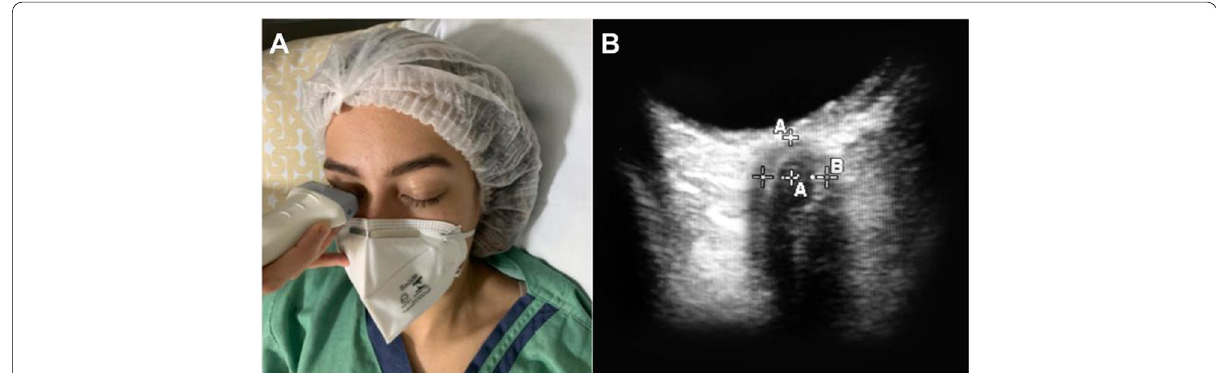
Fig. 5 An algorithm for evaluating intracranial pressure (ICP) and vasospasm by brain ultrasound. CBFV, cerebral blood flow velocity; ICPtcd, intracranial pressure through transcranial Doppler; PI, pulsatility index; ICH, intracranial hypertension. LI, Lindegaard index cerebral artery (MCA)/CBFVm of the extracranial internal carotid